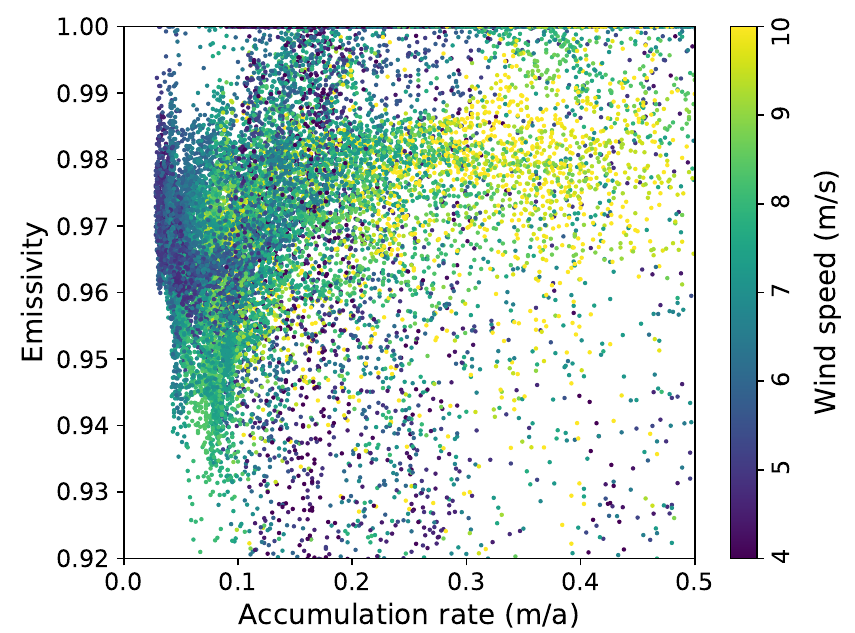
Figure 8. Scatter plot of emissivity vs. accumulation rate. The color scale correspond to the wind speed of ERA Interim at